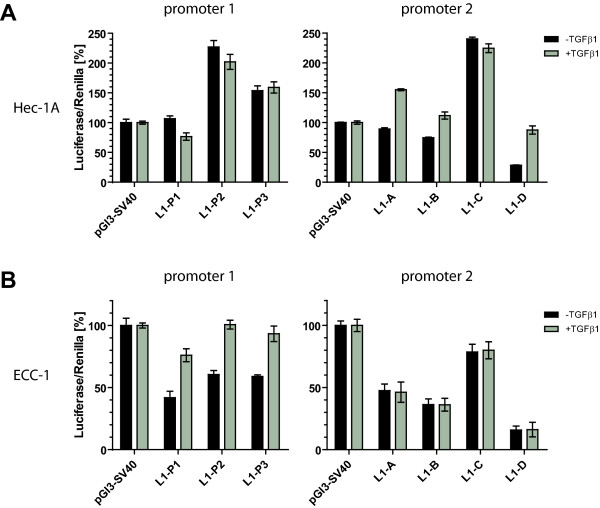
Differential regulation of TGF-β1 treatment on both L1CAM promoter regions. Hec-1A and ECC-1 cells were treated for 5 days with TGF-β1 (10 ng/ml) prior to luciferase transfection. Luciferase levels were analysed 48 h after transfection using a dual luciferase assay. (A) Hec-1A cells show no increased luciferase activity upon stimulation with TGF-β1 on promoter 1, but on promoter 2. (B) ECC-1 cells show an enhanced luficerase activity on promoter 1 when pretreated with TGF-β1, but not on promoter 2. Data ± SD of a representative experiment from n = 2 is shown.